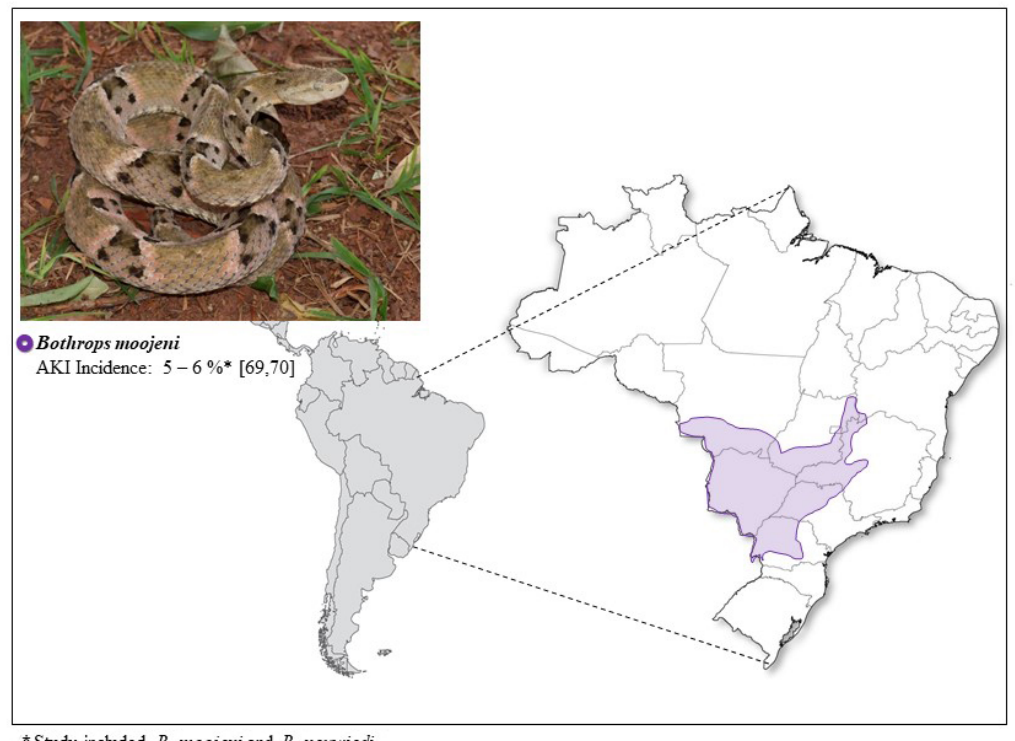
Figure 5. Geographical distribution of Bothrops moojeni (photo courtesy of Paulo Bernarde) and the incidence of